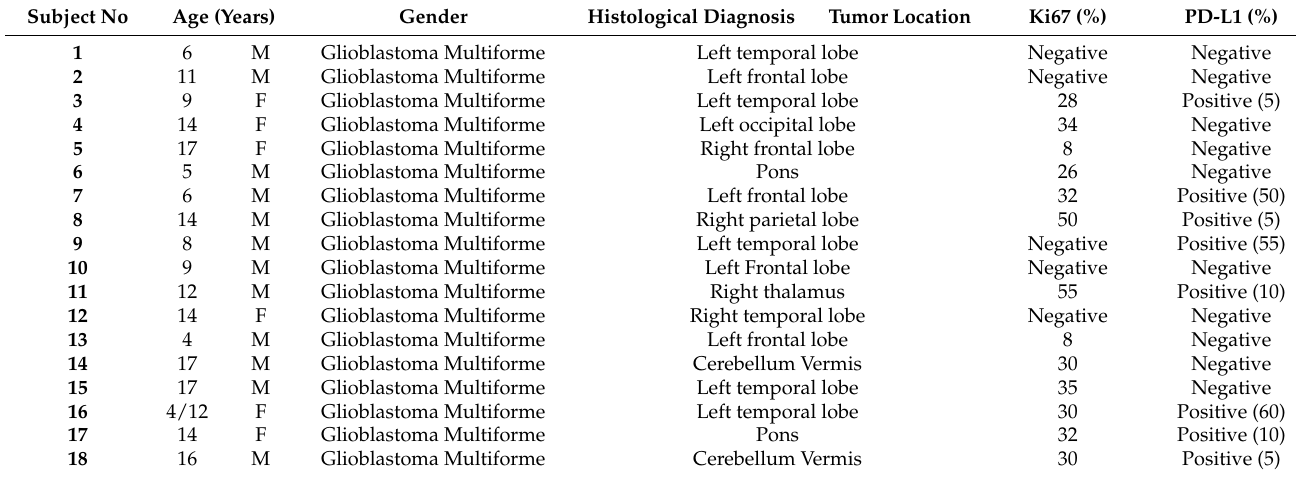
Table 3. Location of Glioblastoma Multiforme (GBM) infiltration among the GBM pediatric cohort ( N = 18).